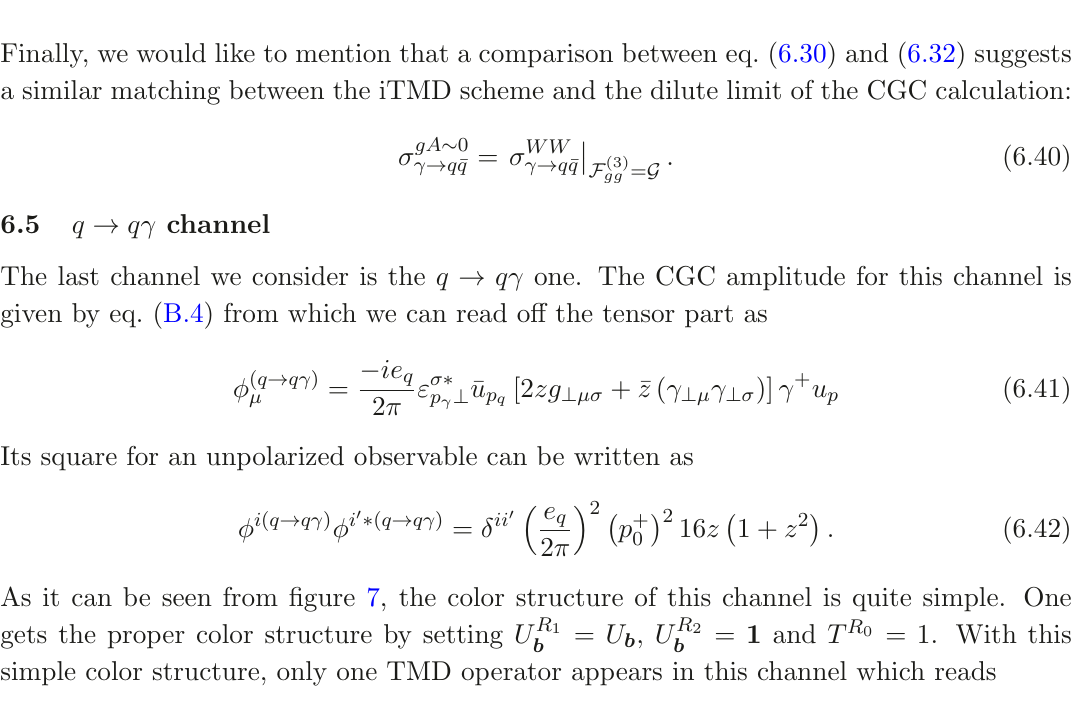
qγ amplitude in an external shockwave background with the appropriate color →